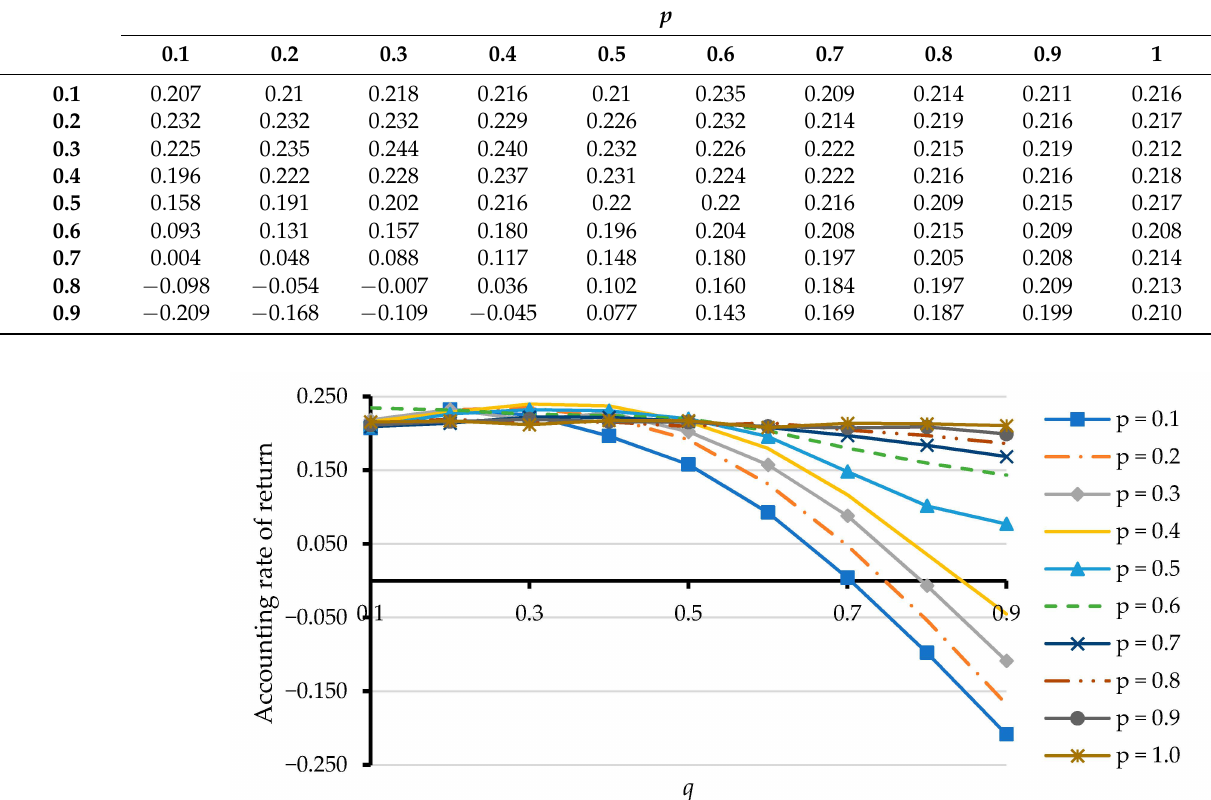
Table 14. Accounting rate of return for different q and p . Matrix representation.